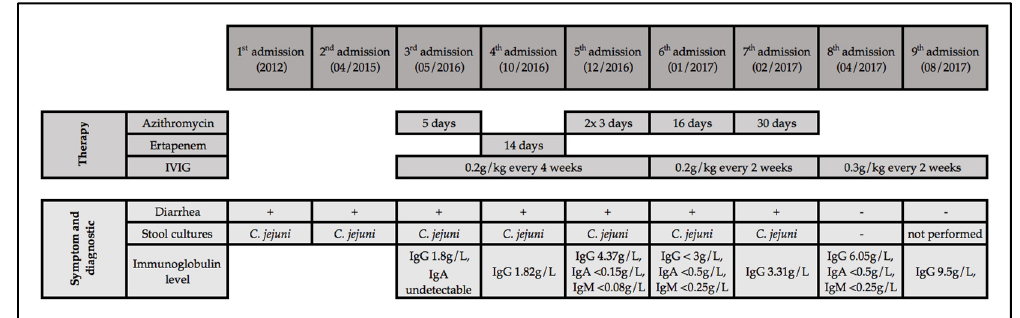
Figure 1. Clinical course of our patient with recurrent Campylobacter enteritis. Notes: IgA, immunoglobulin A; IgM, immunoglobulin M; IgG, immunoglobulin G; IVIG, intravenous immune globulin replacement.